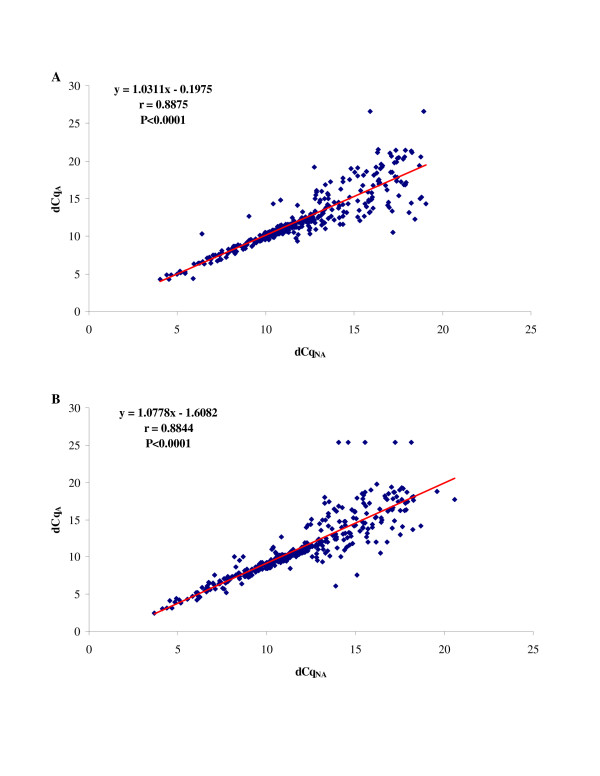
Scatter plots showing the linear correlation (r) between normalized Cq values obtained with the SPIA™ system (dCqA) and by reverse transcriptase of total RNA (dCqNA) in LAN-5 (A) and GI-ME-N (B) cell lines.